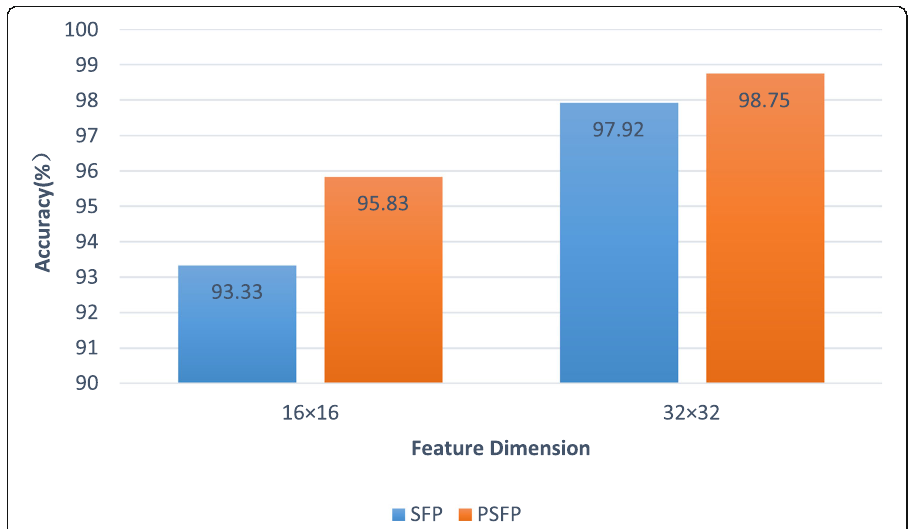
Fig. 9 Comparisons of SFP and PSFP for person-dependent facial expression recognition